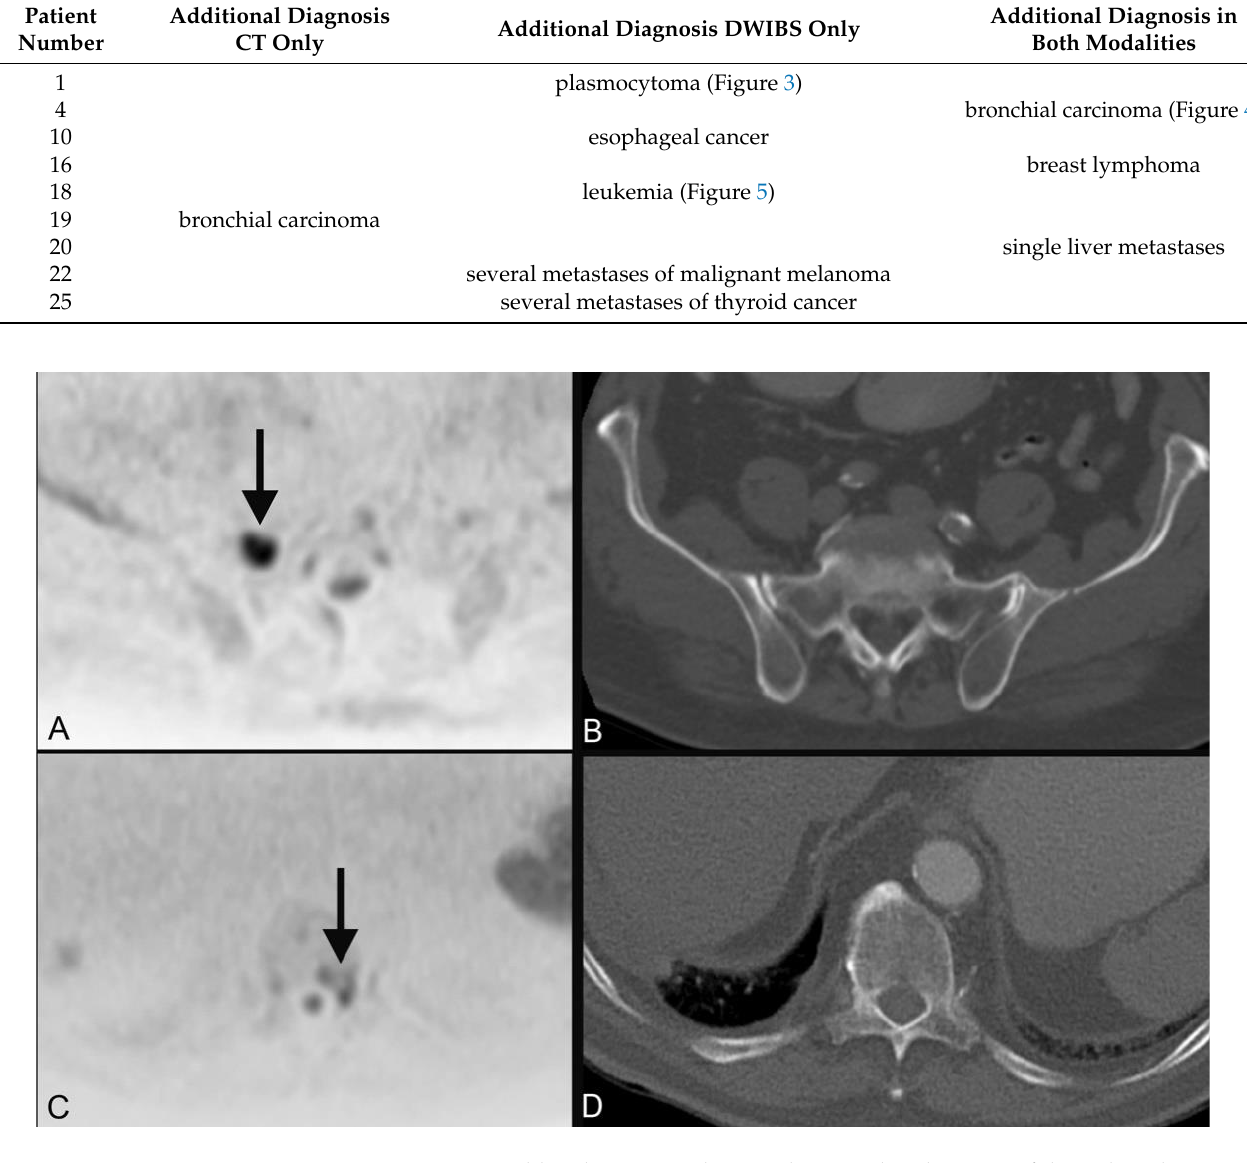
Figure 3. An 85-year-old male patient who was diagnosed with cancer of the right palatine tonsil (cT1 cN2b cM0) showed diffuse spotty diffusion restrictions in DWIBS of the skeletal system with the largest lesions in the right sacral mass ( A , black arrow) and the 11th thoracic vertebrae on the left ( C, black arrow) without correlate in the CT ( B , D ) and was later diagnosed with multiple